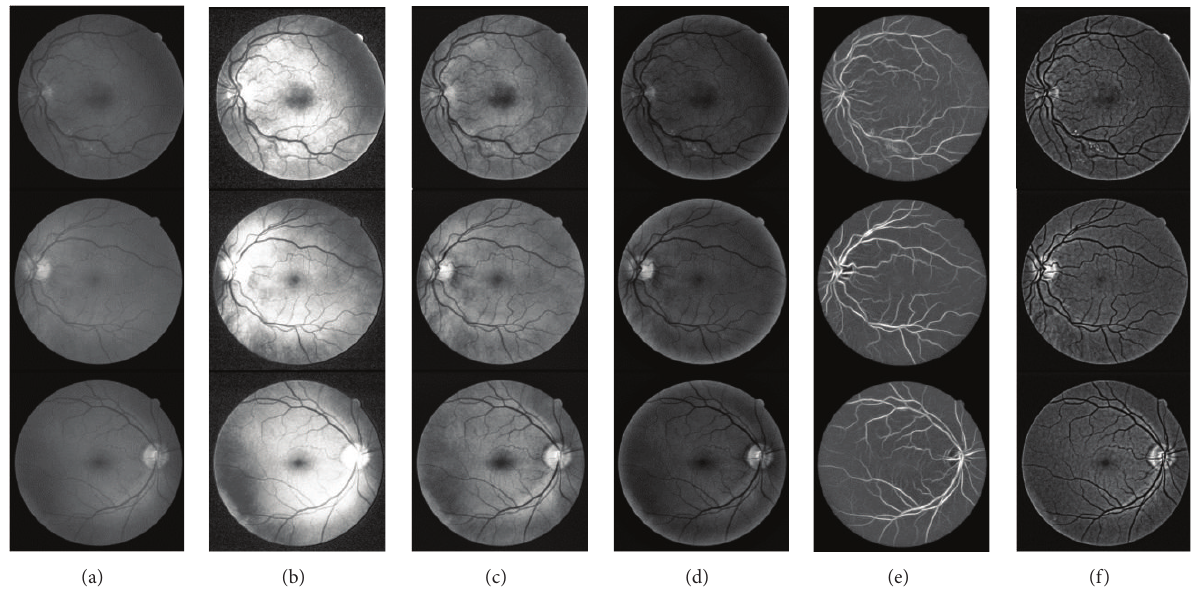
Figure 8: The comparison of image enhancement results of three images in the DRIVE database. (a) The original image; (b) the enhancement results of HE; (c) the enhancement results of CLAHE; (d) the enhancement results using the method in [7]; (e) the enhancement results using the method in [9]; (f) the enhancement results of the proposed method.